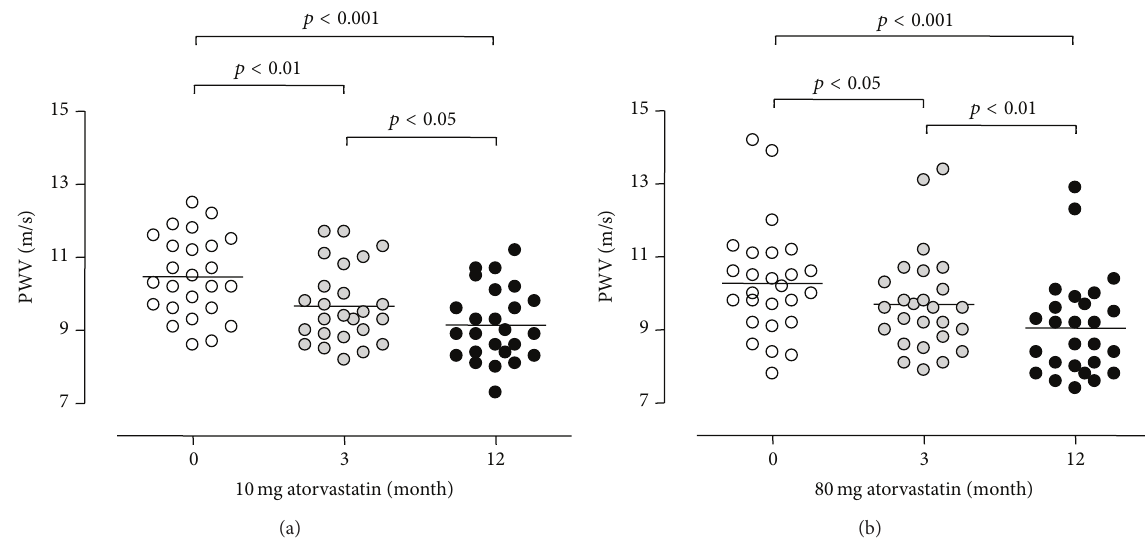
Figure 1: Reduction in PWV in 10 (a) and 80 mg (b) groups, at 3 and 12 months. PWV: pulse wave